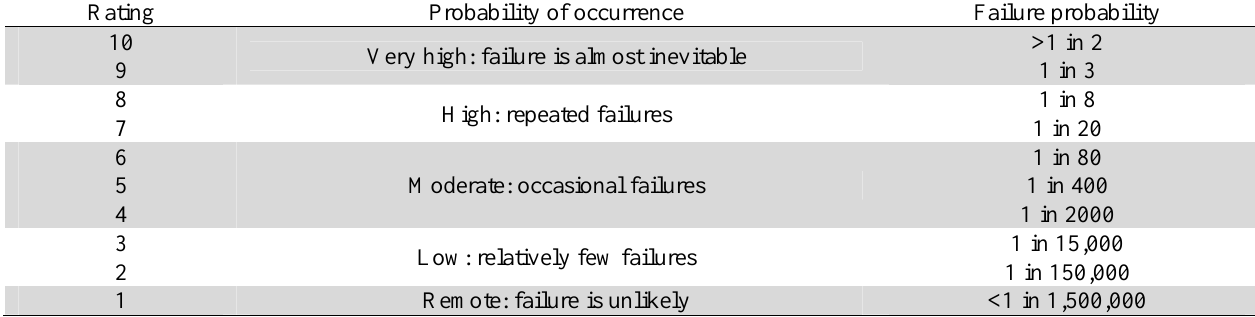
Crisp ratings for occurrence of a failure (Chin et al., 2008; Wang et al., 2009)